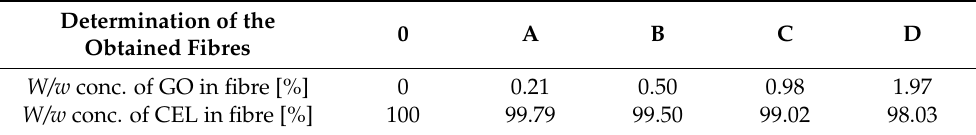
Table 1. Percentage concentrations of cellulose fibres (CEL) and graphene oxide (GO) in individual fibres.